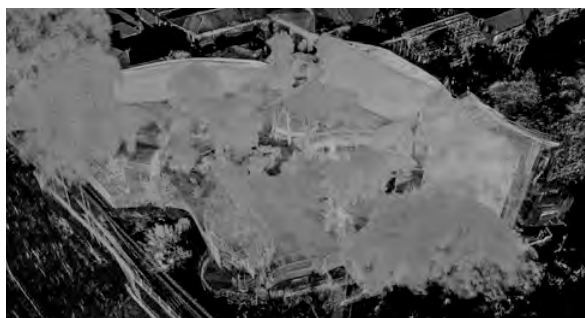
Figure 3: 3D point cloud of the Affandi Museum (D. Grandits and L. Stampfer, 2016)